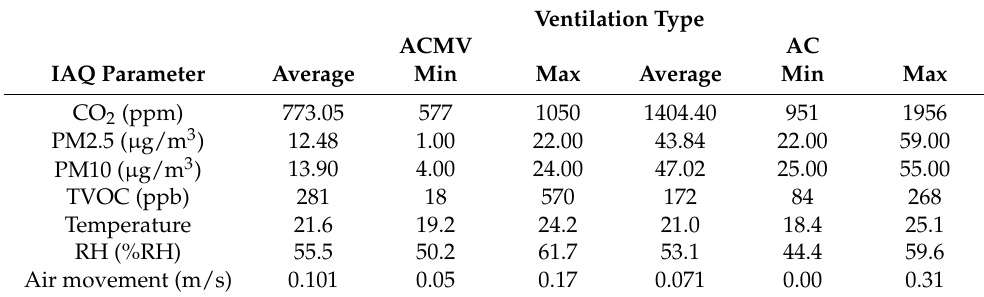
Table 5. IAQ parameters for different types of ventilation at bank operations.